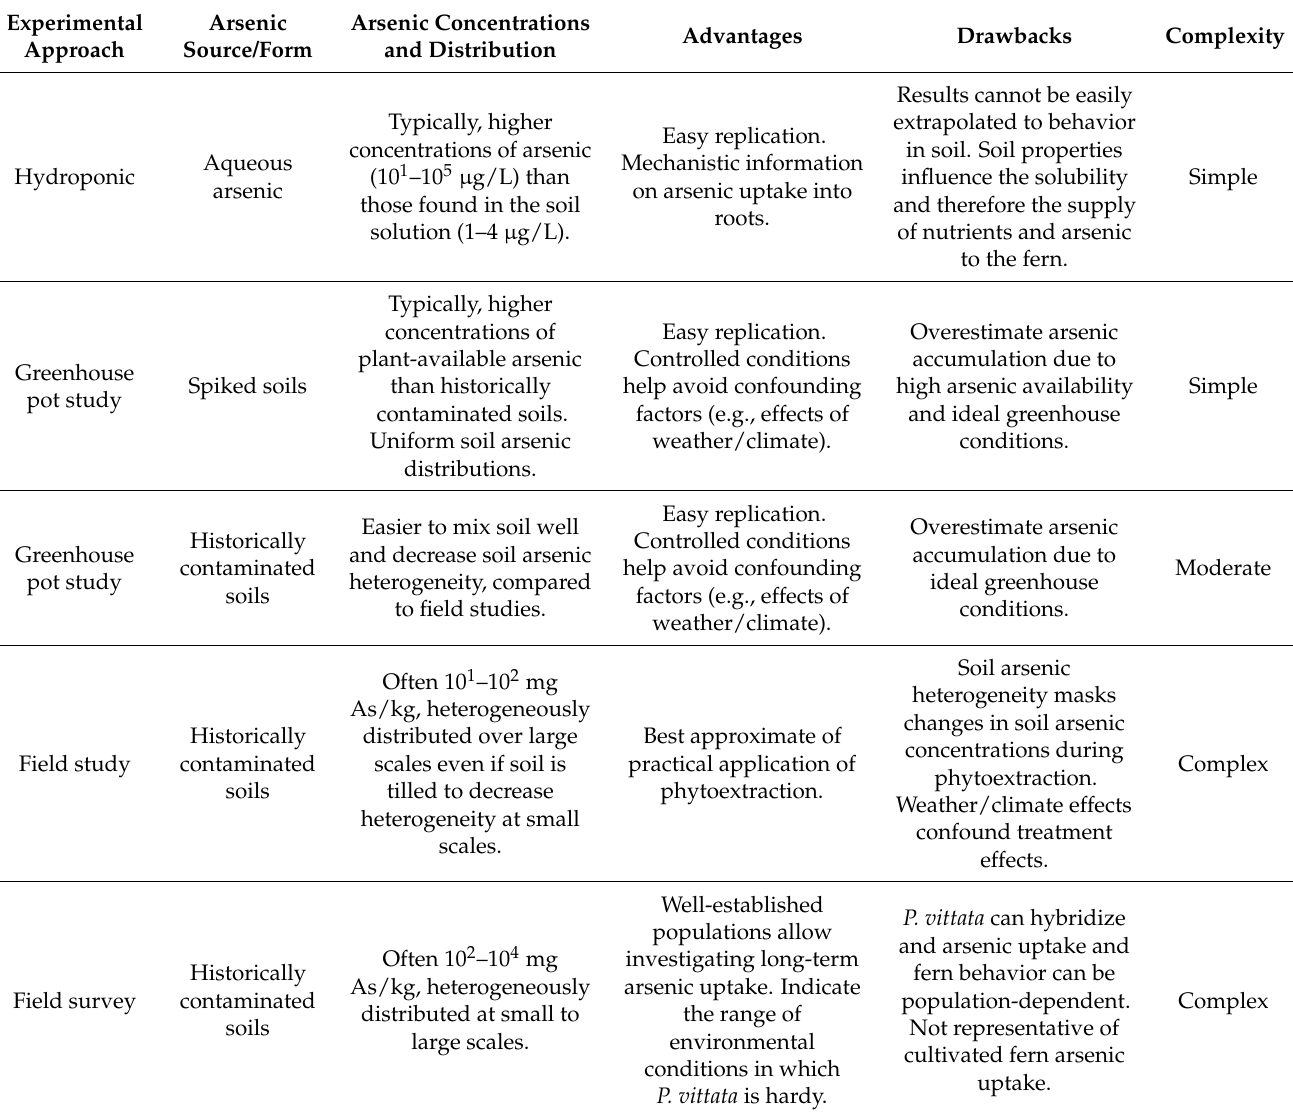
Table 1. Characteristics of experimental approaches commonly used in arsenic phytoextraction